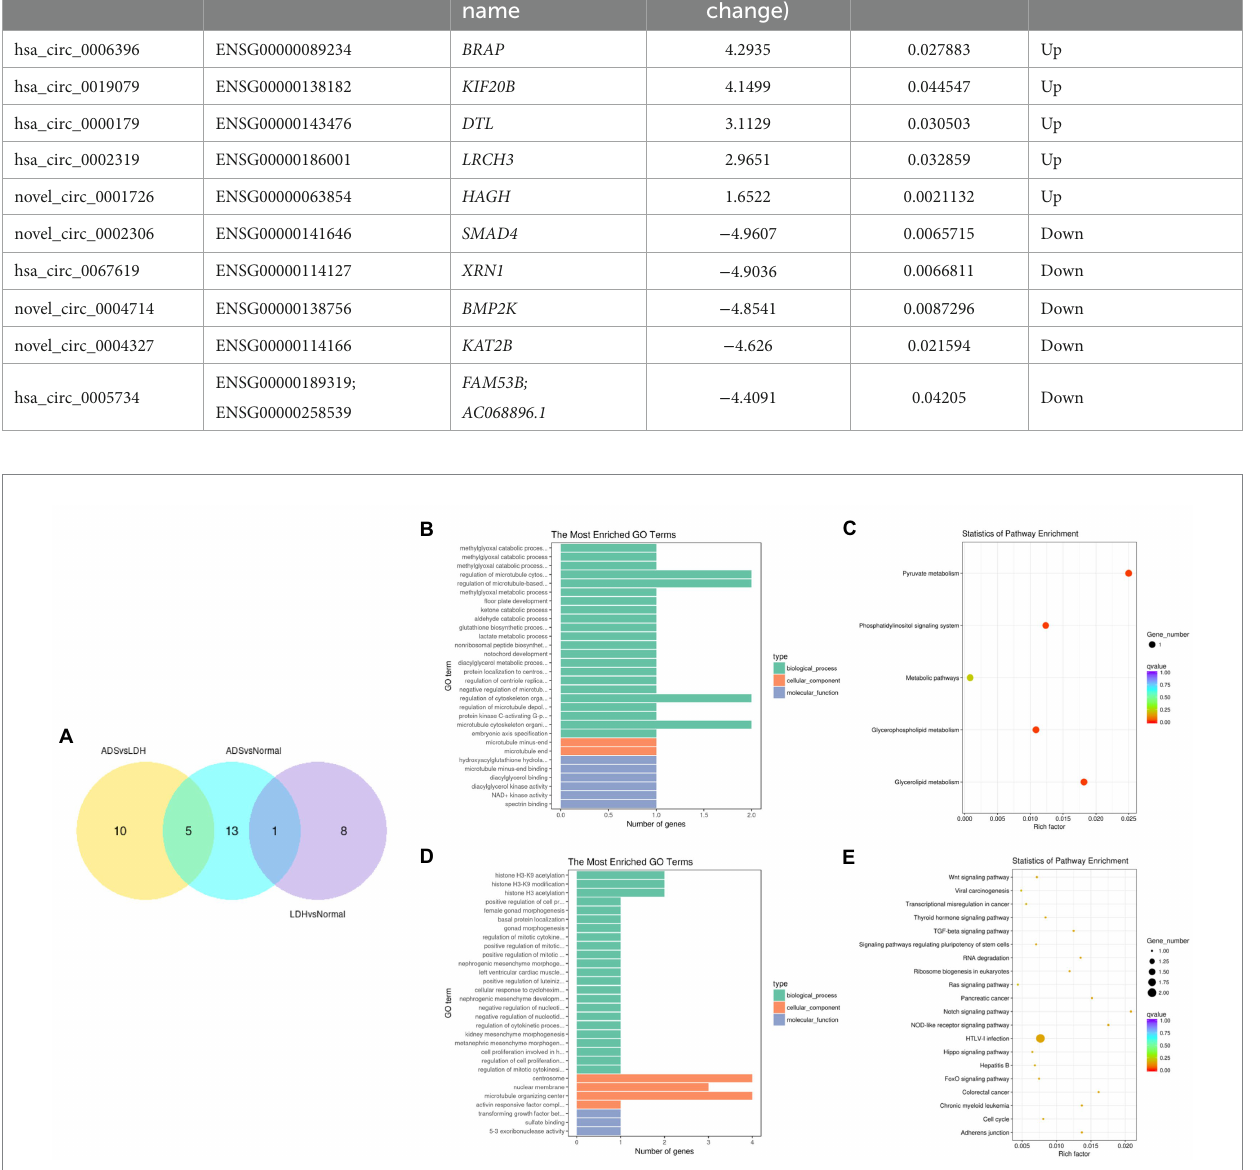
FIGURE 8 Identification of differentially expressed circRNAs (A) The Venn diagram created by the differentially expressed data of circRNAs. (B) The 20 most enriched Gene Ontology terms for the parental genes of 5 co-significantly DE circRNAs in the ADS compared to the LDH and Normal group. (C) The 20 most enriched KEGG pathways for 5 co-significantly DE circRNAs. (D) The 20 most enriched Gene Ontology terms for the parental genes of 10 significantly DE circRNAs in the ADS compared to the LDH group. (E) The 20 most enriched KEGG pathways for 10 significantly DE circRNAs. Enriched GO terms are on the vertical axis, and the number of annotated differentially expressed genes associated with each GO term is indicated on the horizontal axis. The size of the symbol represents the number of genes, and the colors represent p -value in